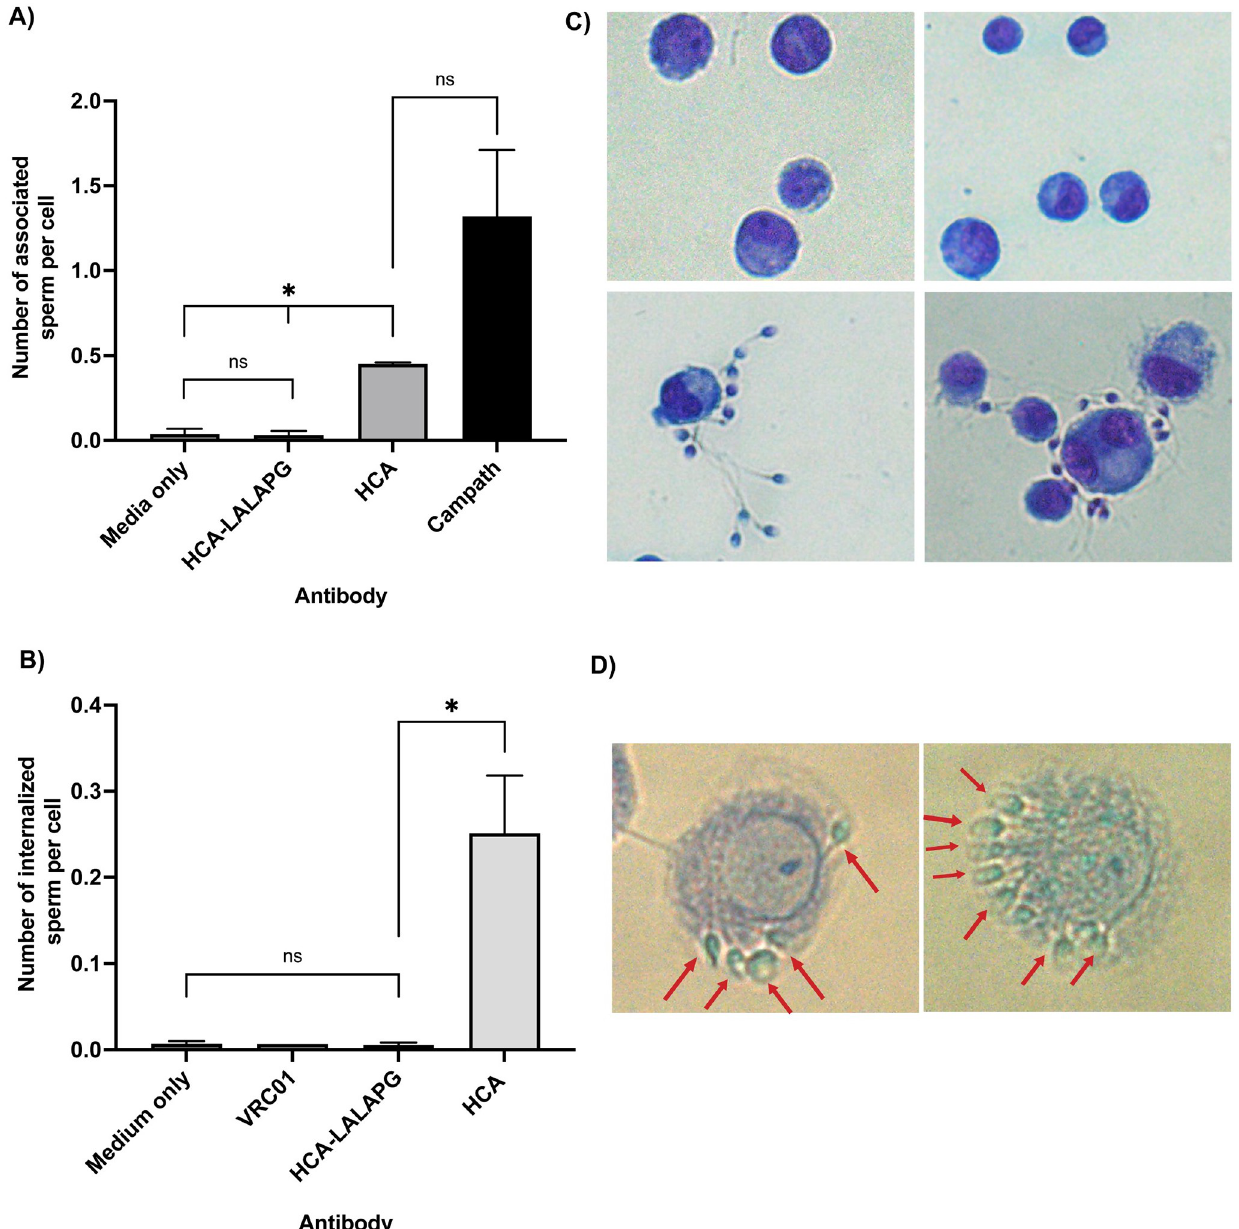
Fig 5. Antibody-dependent sperm phagocytosis. A) Significantly more sperm were associated with U937 macrophages in HCA-treated cultures than in cultures treated with HCA-LALAPG or medium-only control (p = 0.0128, p = 0.0131, respectively). “Associated sperm” were defined as those either attached to the surface of the macrophage (i.e., at the beginning of the phagocytosis process), or inside the cell. Campath, an anti-CD52 monoclonal antibody known to mediate ADCP effector function, was used as a positive control. Final antibody concentrations were 50 μ g/mL. B) The number of internalized sperm per macrophage was quantified following a 2.5-hour incubation with antibody-treated sperm. Final antibody concentrations were 50 μ g/ mL. The number of internalized sperm was significantly higher following treatment with HCA than with HCA-LALAPG, medium-only control, or VRC01 isotype control (p = 0.037; negative control run twice, isotype control run once). (C) Images of macrophages incubated with sperm exposed to either medium-only (top left), HCA-LALAPG (top right), HCA (bottom left), or Campath (bottom right). Images were taken at 200x magnification. (D) Sperm internalization post-HCA treatment (red arrows) by U937 macrophages. Images were taken at 400X magnification. Data are expressed as mean ± SEM of three independently performed experiments. Statistical analyses were conducted using either repeated measures one-way ANOVA or mixed-effects analysis of log-transformed data followed by Tukey multiple comparisons